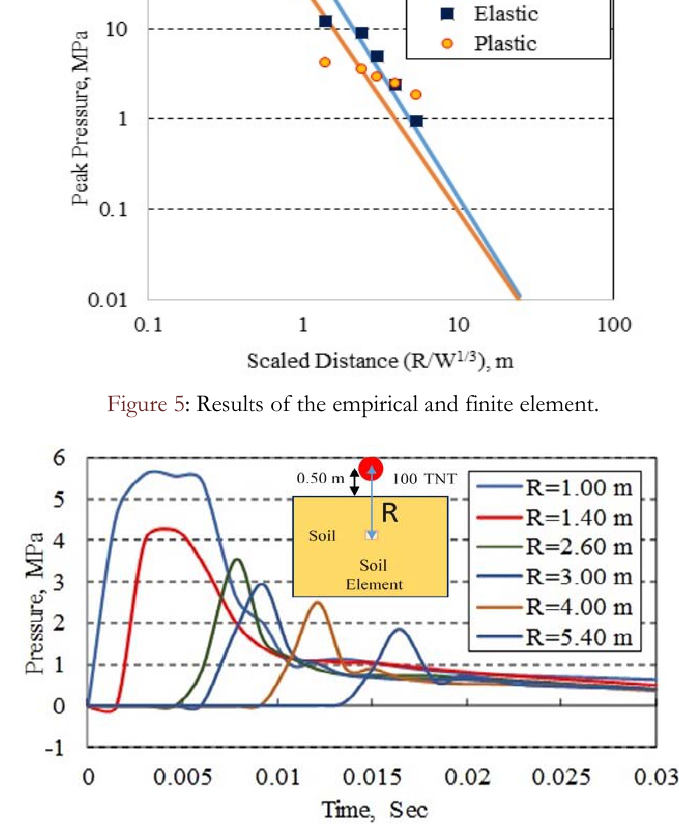
Figure 6: Pressure-time history in soil.